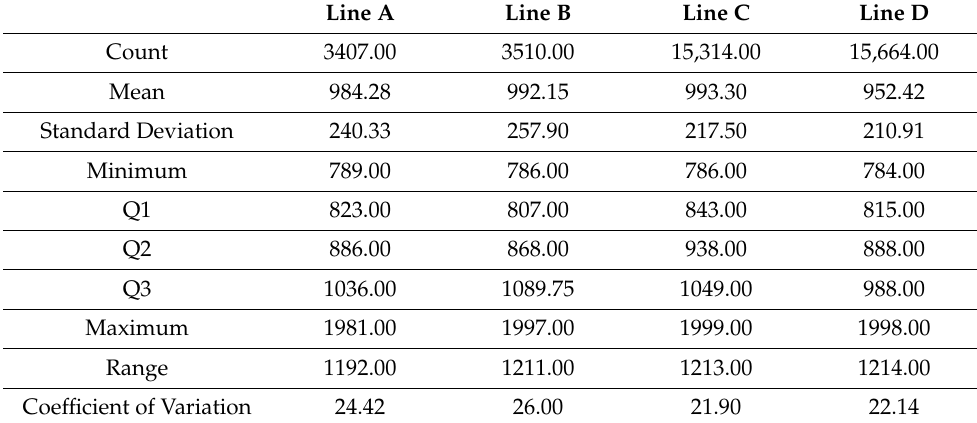
Table 1. Descriptive statistics (in seconds), per line.